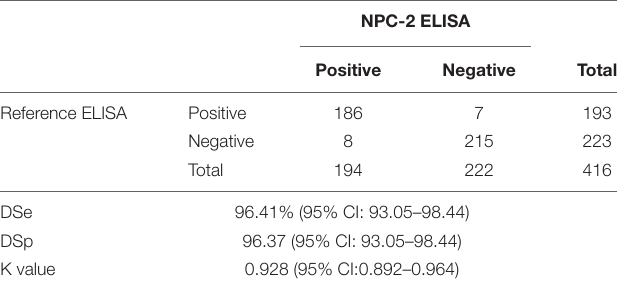
TABLE 2 | Diagnostic sensitivity (DSe), diagnostic specificity (DSp) and kappa coefficient (K) of the NPC-2 ELISA compared to the reference ELISA.